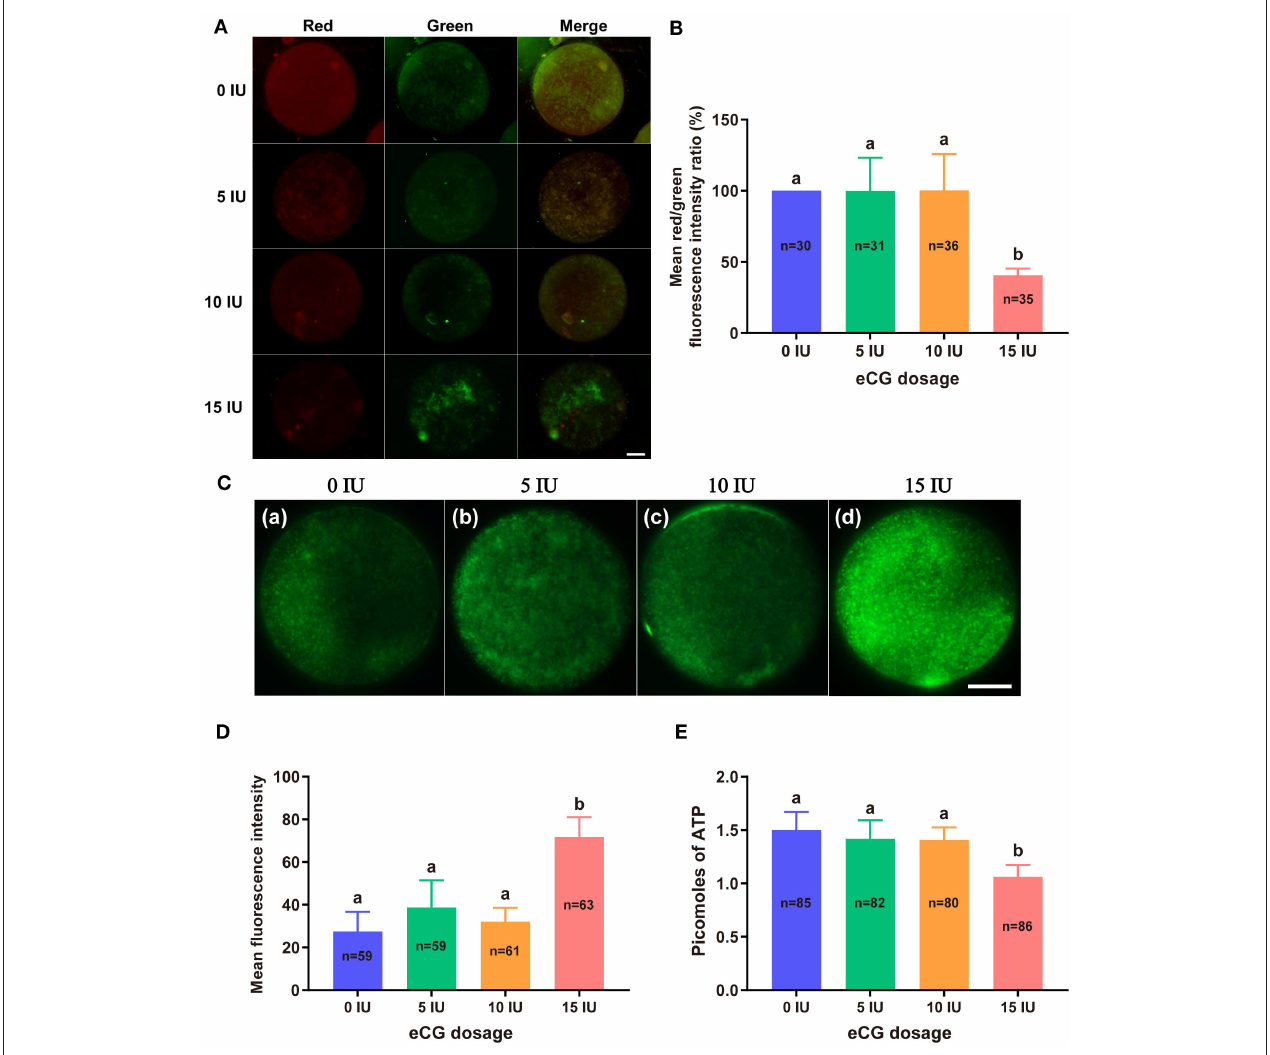
FIGURE 3 | Effects of different eCG doses on the mitochondrial function of IVF-derived mouse embryos. (A) Representative images of the MMP in embryos after administration of eCG at doses of 0, 5, 10, and 15 IU. Scale bar = 20 µ m. (B) Ratios of the red/green FI following JC-1 staining. The mean red/green FI ratio of the control (0 IU eCG injection) group was set to 100%. (C) Representative images of mitochondrial activity in embryos after administration of eCG at doses of 0, 5, 10, and 15 IU (a–d). Scale bar = 20 µ m. (D) Magnitude of mitochondrial activity in IVF-derived embryos after administration of different doses of eCG. The mitochondrial activity in the embryos is represented by the mean FI. (E) ATP content of individual embryos from mice administered different doses of eCG. All the values are presented as the means ± SD s. Different letters above the columns indicate significant differences ( P < 0.05). Each experiment was performed in triplicate, and n shows the total number of embryos